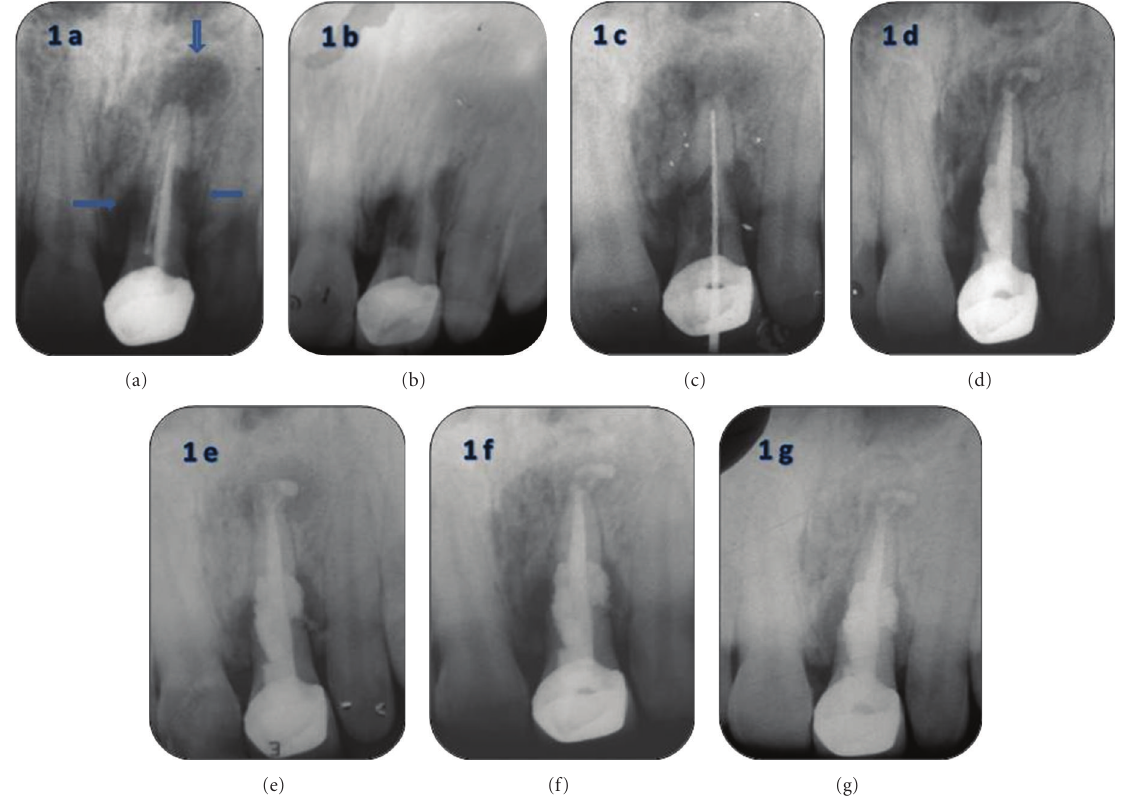
Figure 1: (a) Preoperative periapical radiograph showing periapical lesion and external apical and lateral root surface resorption in a maxillary left central incisor. The radiograph also reveals previous poor quality obturation. (b) Radiograph after removal of old gutta percha filling showing root canal outline completely visible through resorption defect. Bone resorption adjacent to resorption lacunae on root is also evident. (c) Working length radiograph. (d) Immediate postobturation radiograph showing adequate density of MTA obturation without voids and good adaptation of MTA to root contours. (e) Six-month followup periapical radiograph revealing stability of resorption and periapical healing. (f) Advanced osseous healing of periapical tissues and initiation of repair adjacent to lateral root surface resorption at 12 months. (g) An 18-month radiographic view showing complete regeneration of periradicular tissues and advanced osseous healing evident in the lateral periodontal